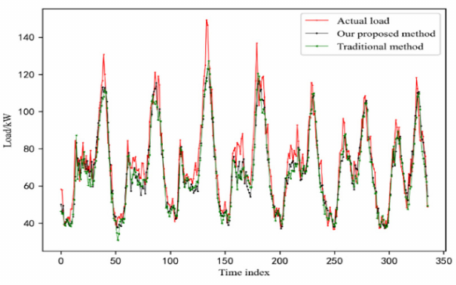
Figure 10. The detailed forecasting results at 336 points from 25 March to 31 March.